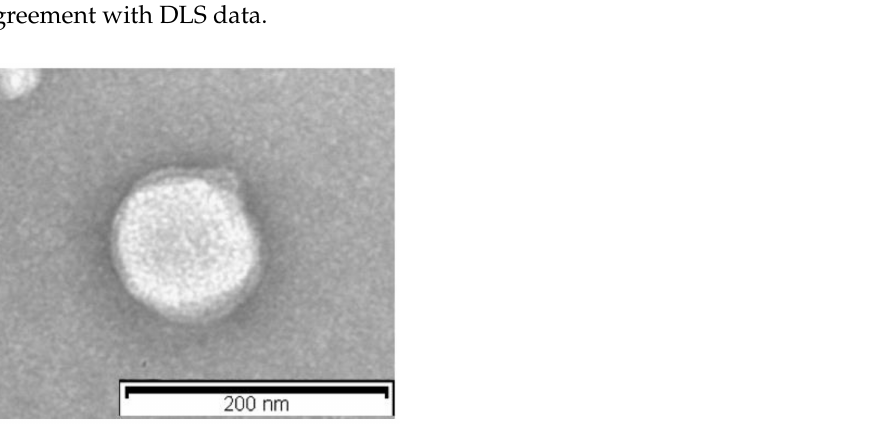
Figure 2. Transmission electron microscopy images of LN-ODAF. The scale bar represents 200